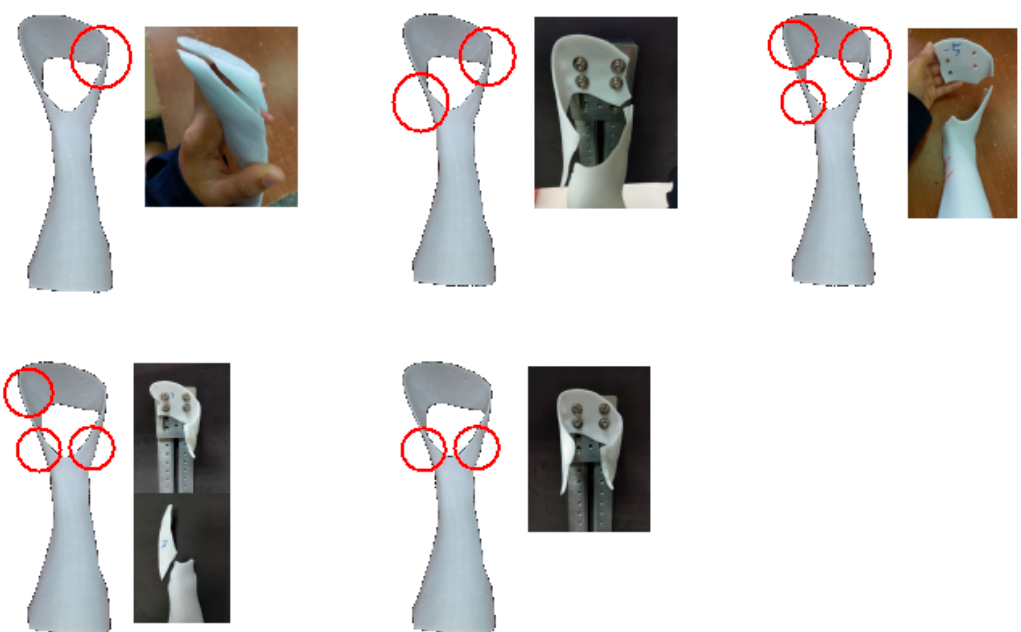
Figure 6. Different patterns of the fractured 3DP-AAFOs. Circle indicates the locations of the fracture.